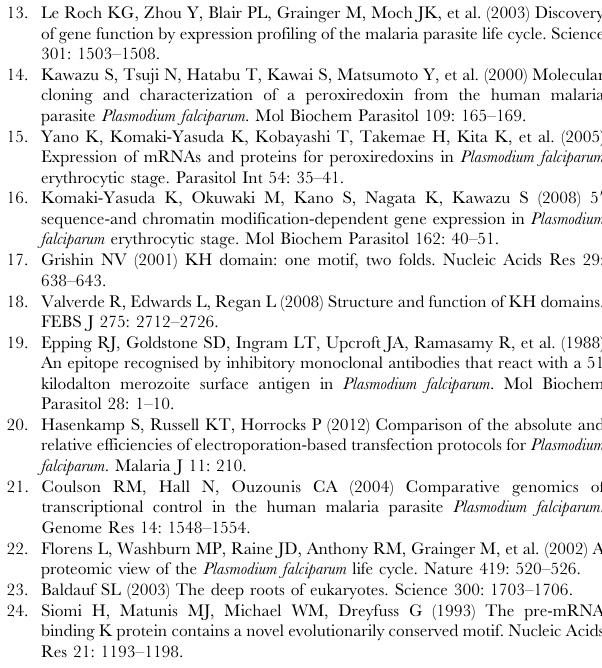
three independent assays. Error bars represent standard devia- tions. (TIF) Figure S6 Model scheme for PREBP interaction with PRE sequence and activation of the transcription of pf1- cys-prx . (TIF) Table S1 Summary of the purification of PREBP from the parasite nuclear extract. (DOC) Table S2 List of detected P. falciparum proteins by LC- MS/MS. (DOC) Table S3 List of primers used for the plasmid construc- tions. (DOC) Method S1 Preparation of recombinant proteins using the cell free translation system. (DOC) Method S2 Quantitative real-time